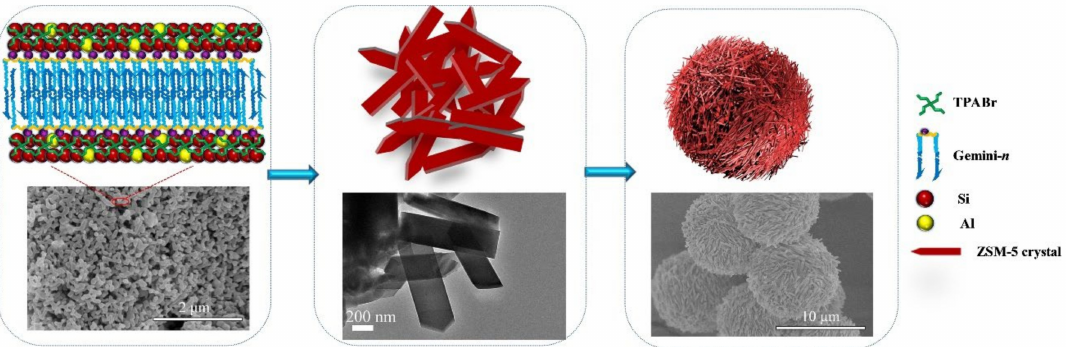
Figure 8. Proposed formation process for the synthesis of HZSM-5 using Gemini-n as a mesoporous structure directing agent. Reproduced with permission from Reference [48]. Copyright (2021), Wiley-VCH